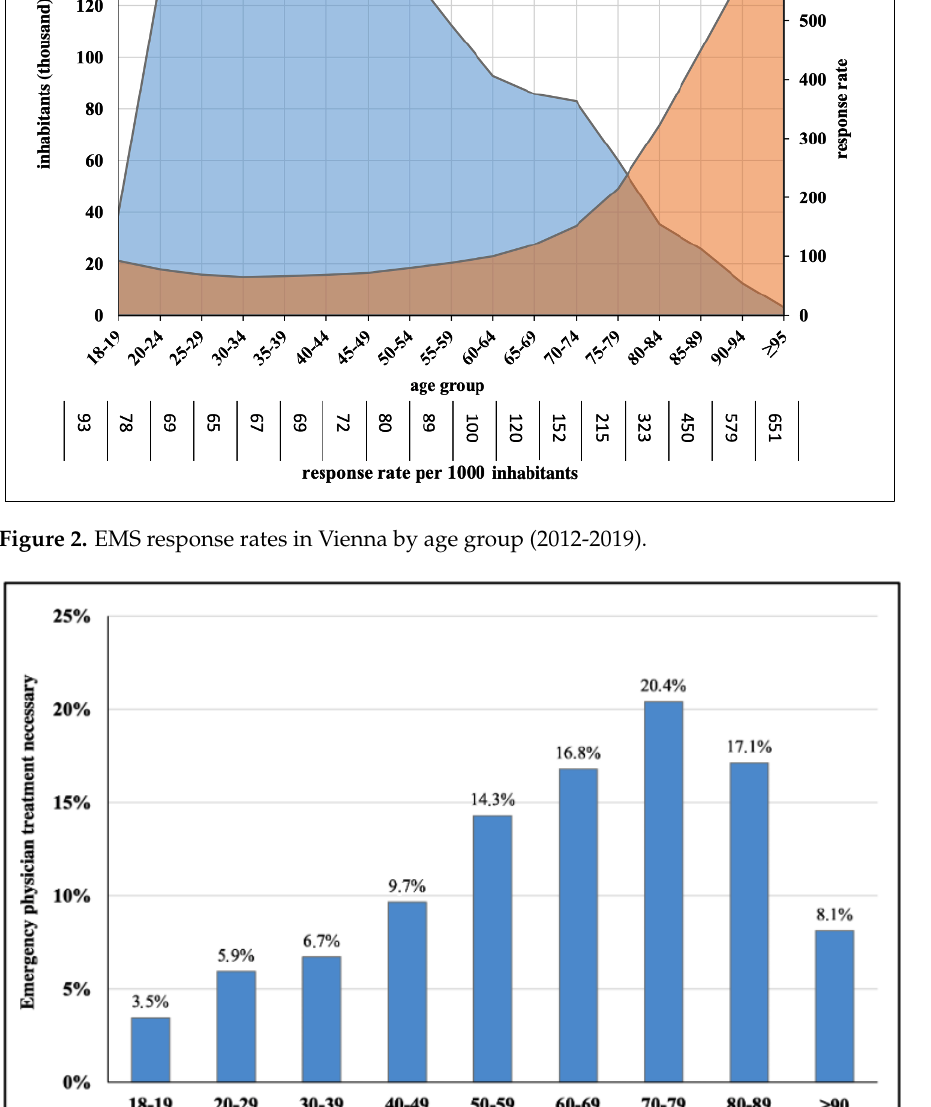
Figure 2. EMS response rates in Vienna by age group (2012-2019).